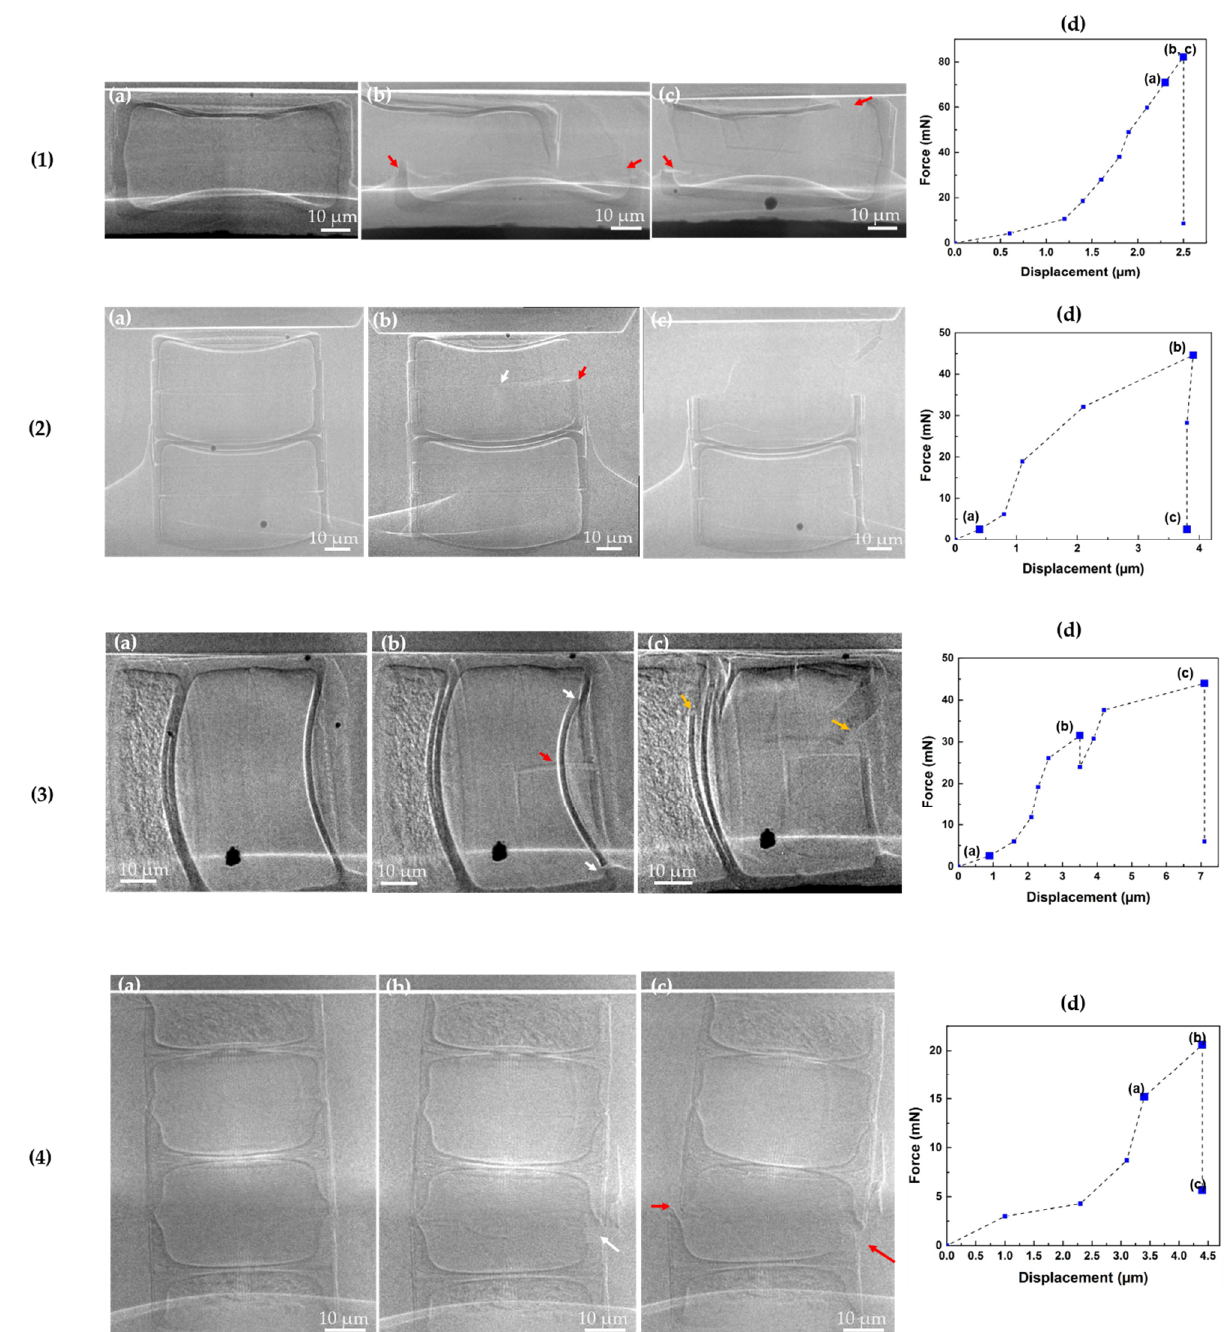
Figure 6. In situ mechanical compression tests on studying the mechanical behavior of the four different fossil frustules ( 1 – 4 ). ( a – c ) Radiographs recorded during the mechanical test and ( d ) corresponding load-displacement curves. The enlarged data points in (d) correspond to the radiographs in (a–c). Dashed lines are a guide for the eye.